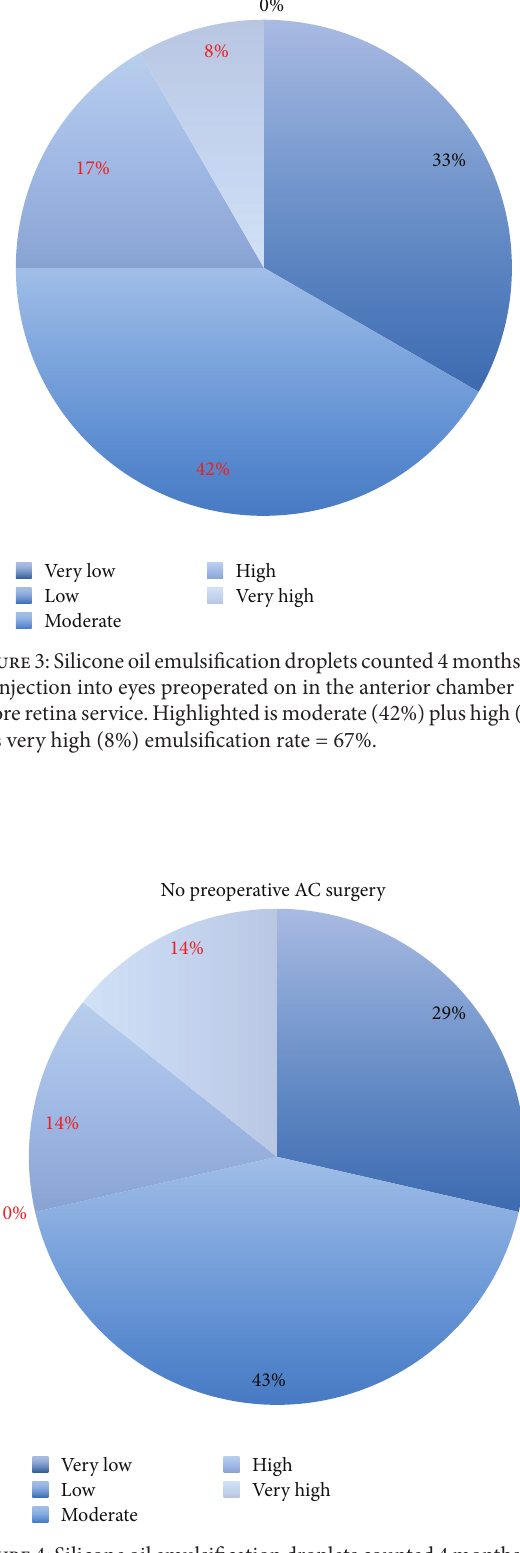
Figure4:Siliconeoilemulsificationdropletscounted4monthsafter oil injection into eyes not preoperated on in the AC before retina service. Highlightedismoderate(0%)plushigh(14%)plusveryhigh (14%) emulsification rate =